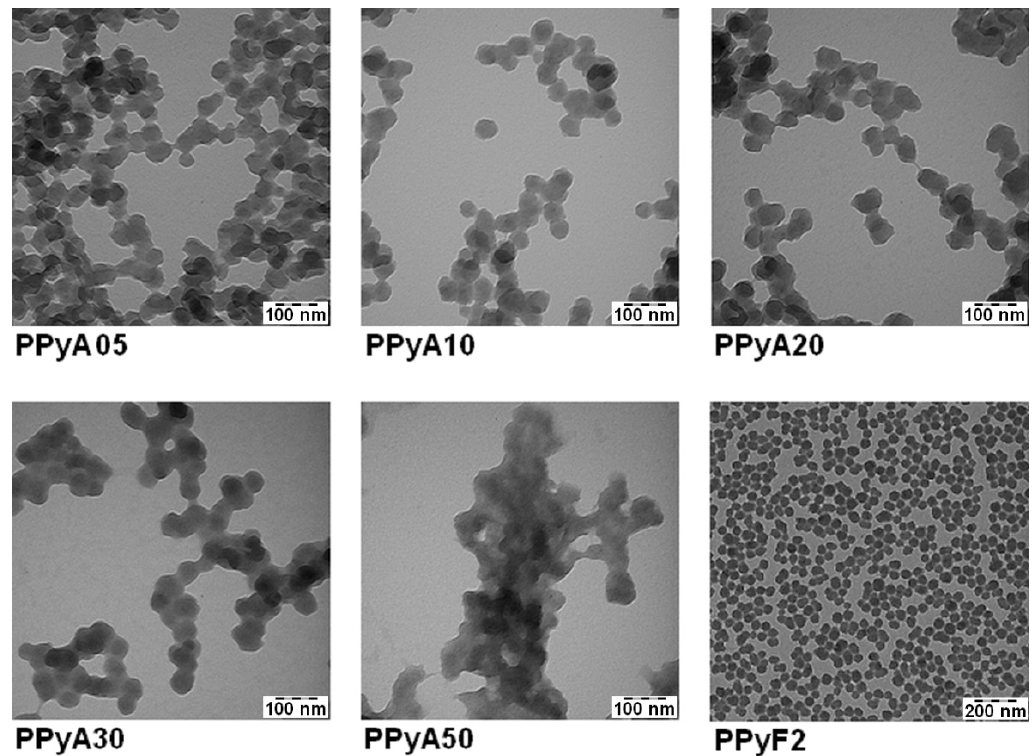
Figure 1. Transmission electron microscopy (TEM) micrographs of the polypyrrole nanoparticles.